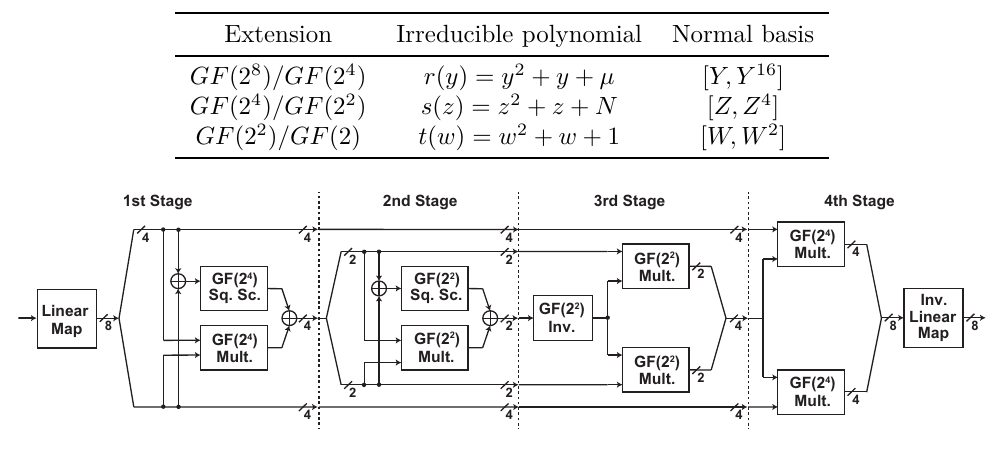
Table 2: Irreducible polynomials and normal bases for the tower field representation